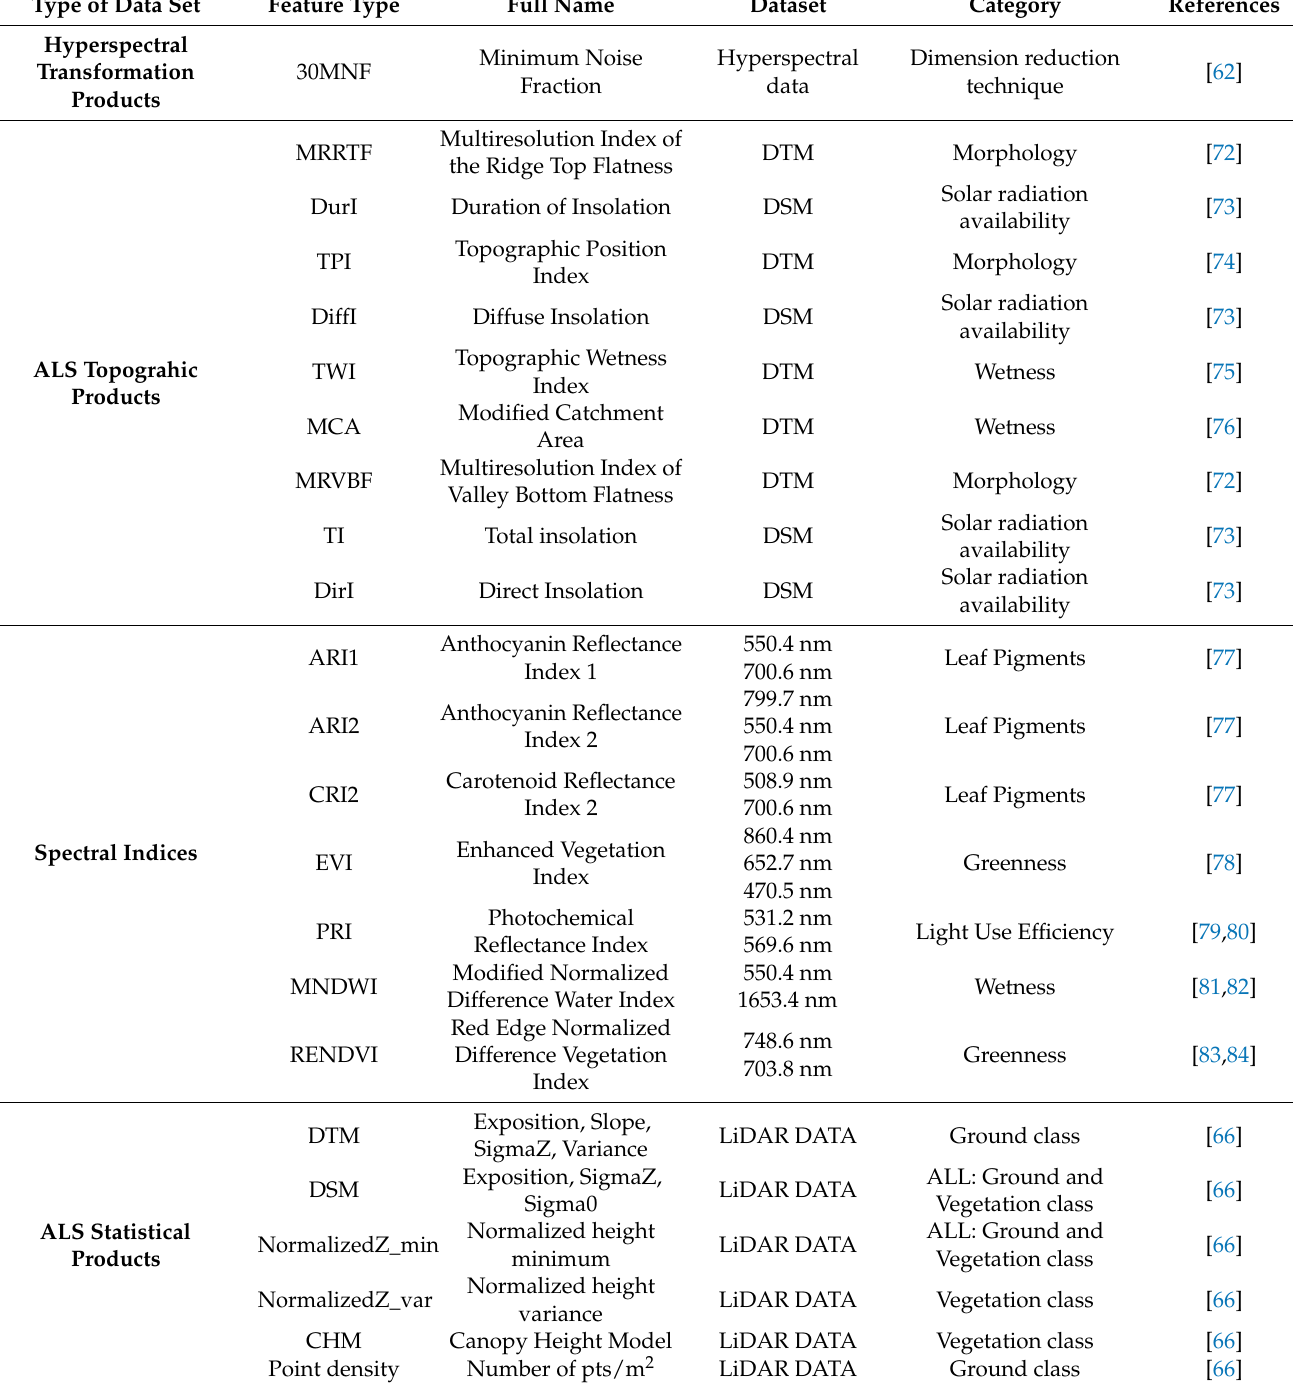
Table 6. Recommended RS sub-products in the identification of alkaline